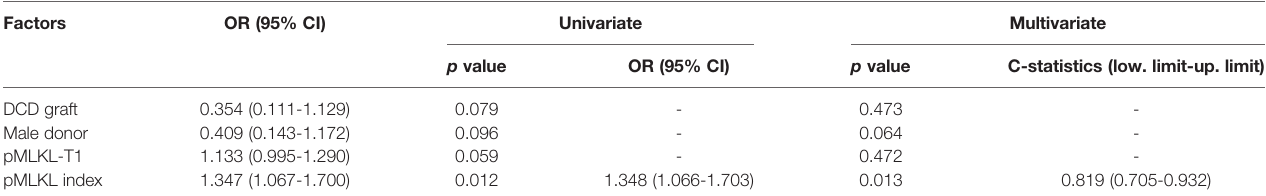
TABLE 2 | Univariate and multivariate analysis for risk factors for post-transplant EAD. Factors OR (95% CI) Univariate Multivariate